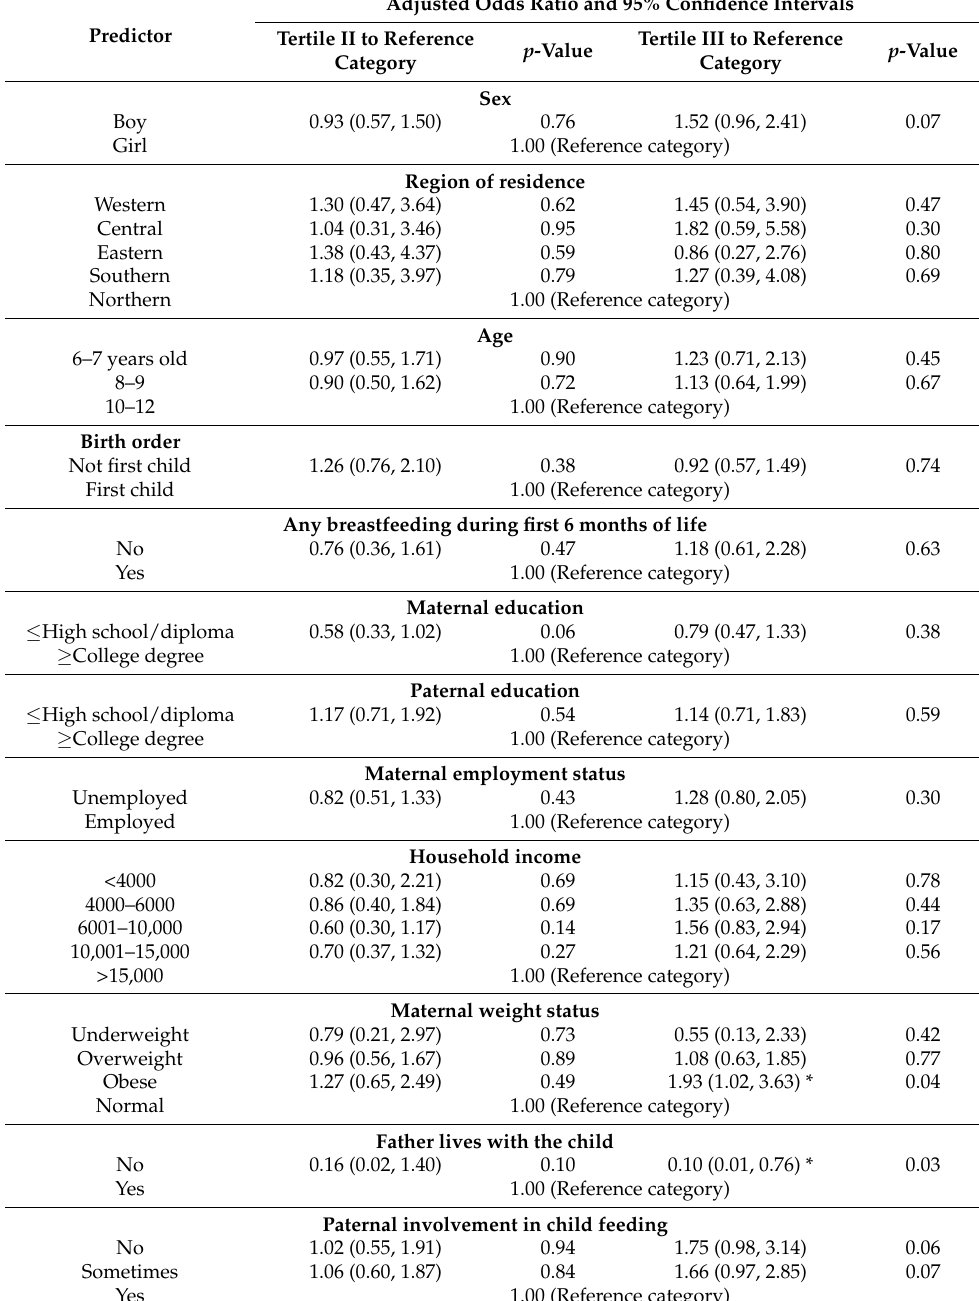
Table 2. Adjusted odds ratio for the association between child characteristics and picky eater status a .